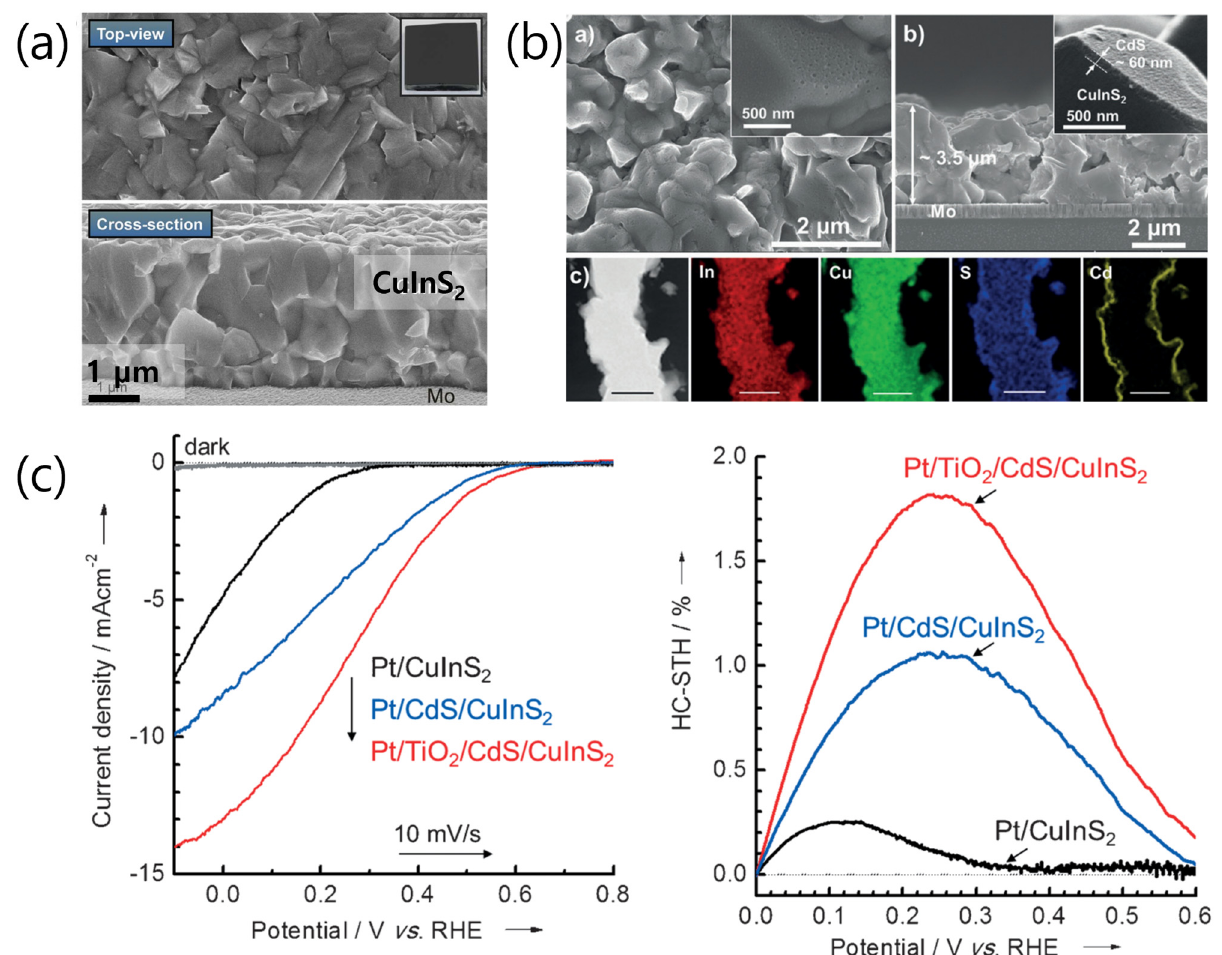
Figure 4. Crystal morphology of CuInS 2 thin films prepared by ( a ) sputtering [33] and ( b ) electrodeposition/sulfurization [42]. ( c ) Linear sweep voltammetry (LSV) profiles and HC-ABPE data of CuInS 2 -based photocathodes fabricated by electrodeposition/sulfurization [42]. Reproduced from ref. [29] with permission of the Royal Society of Chemistry. Reproduced from ref. [39] with permission from Wiley-VCH.